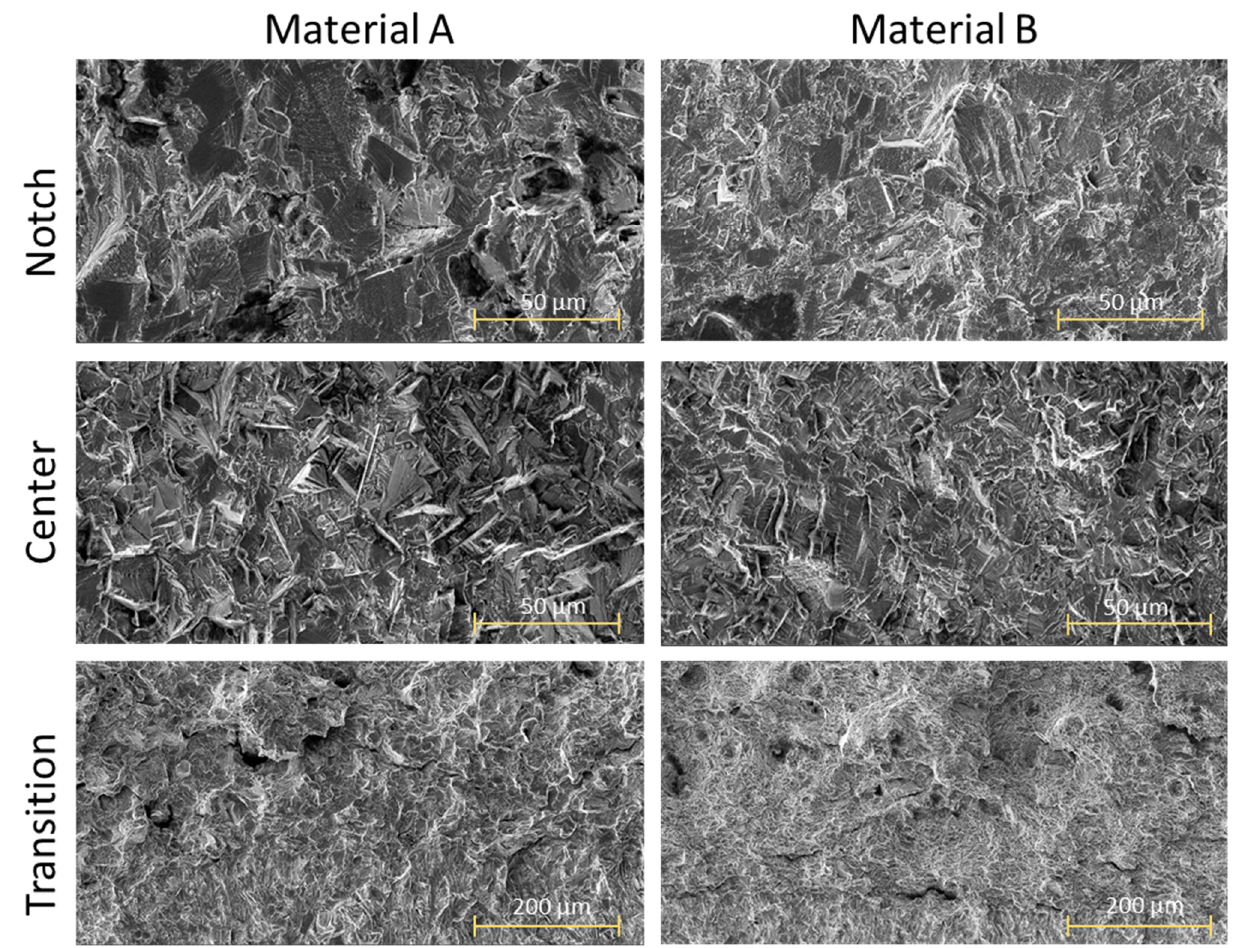
Figure 7. Comparison of fracture surfaces with comparable Δ K at the notch, center and transition area of Material A and Material B.